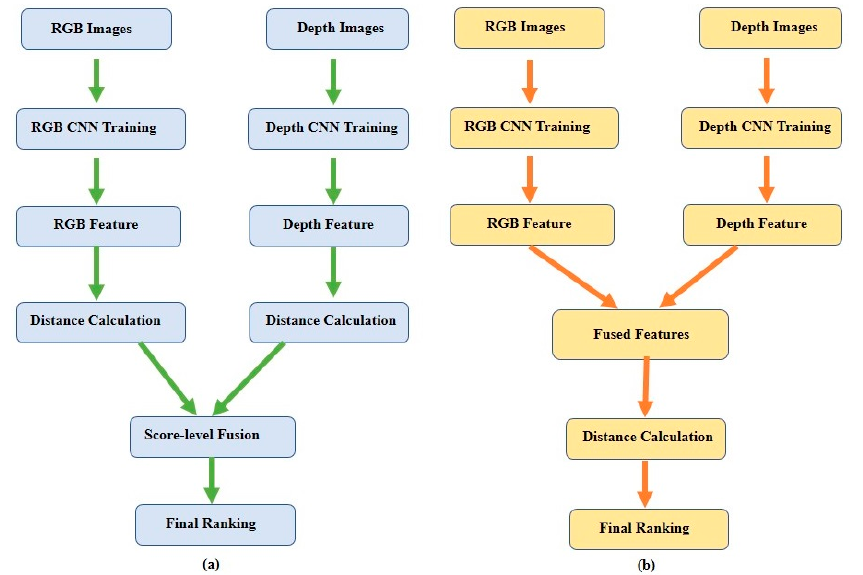
Figure 5. A flowchart of the RGB–depth image-based Re-ID framework. ( a ) Score-level fusion and ( b ) feature-level fusion techniques.